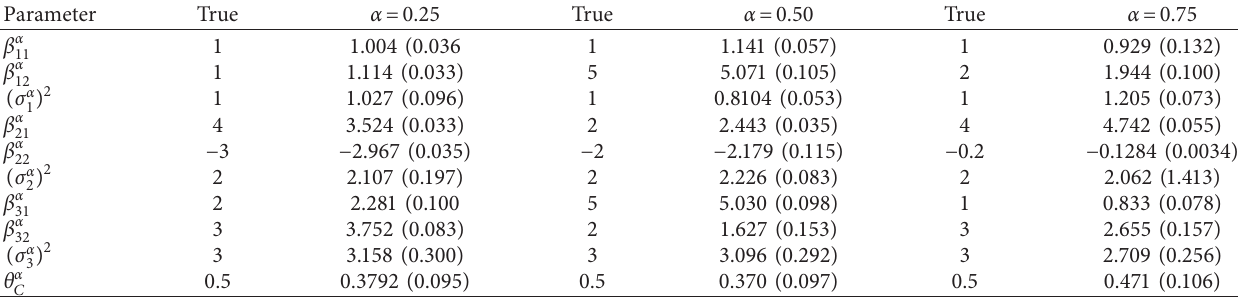
Table 2: Mean and standard deviation of the Bayesian estimate of the Clayton copula at three quantile levels.